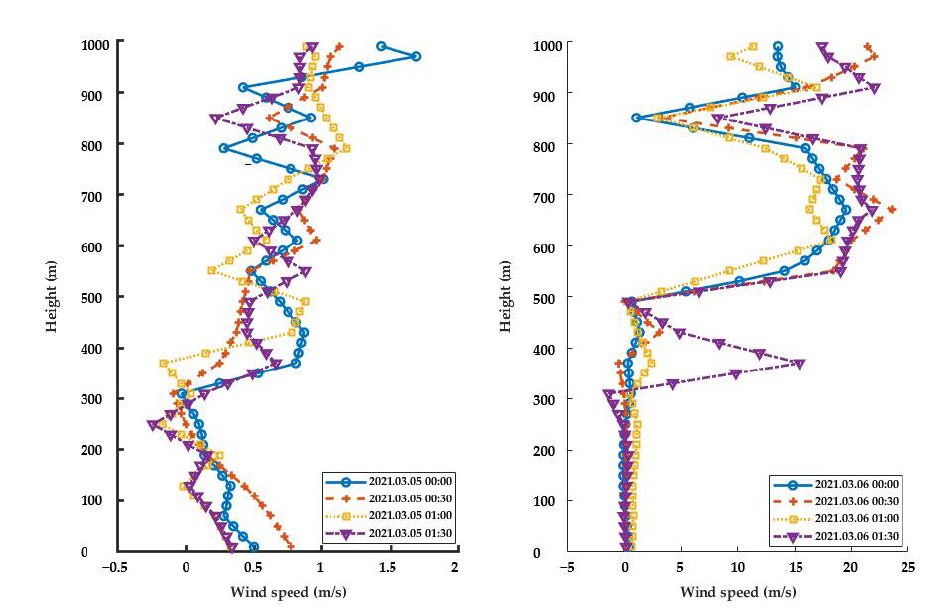
Figure 7. Wind profiles obtained for two consecutive days in the vertical direction.